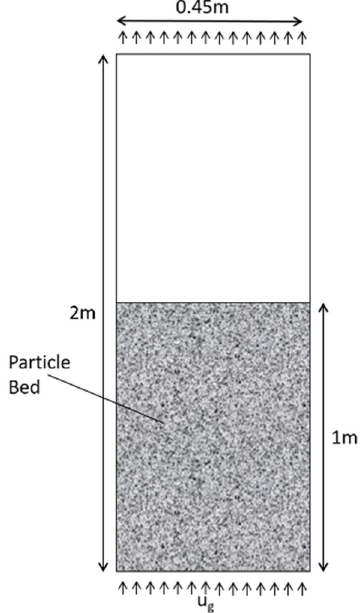
Figure 6. Schematic of initial setup for pilot scale simulation. The gray shaded area represents the region in which sorbent particles are originally placed.